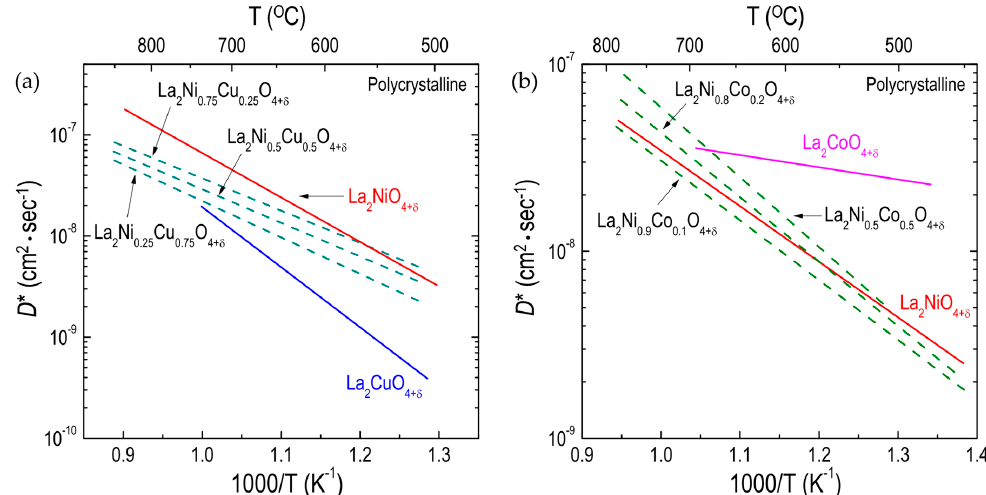
Figure 7. Arrhenius plots of oxygen tracer diffusivity ( D *) for different RP oxides: ( a ) effect of Ni substitution on the B site on D * for La 2 Ni 1 − x Cu x O 4+ δ (Refs. [51,98]) polycrystalline; and ( b ) effect of Ni substitution on the B site on D * for polycrystalline La 2 Ni 1 − x Co x O 4+ δ (Refs. [77,94]) polycrystalline oxides.